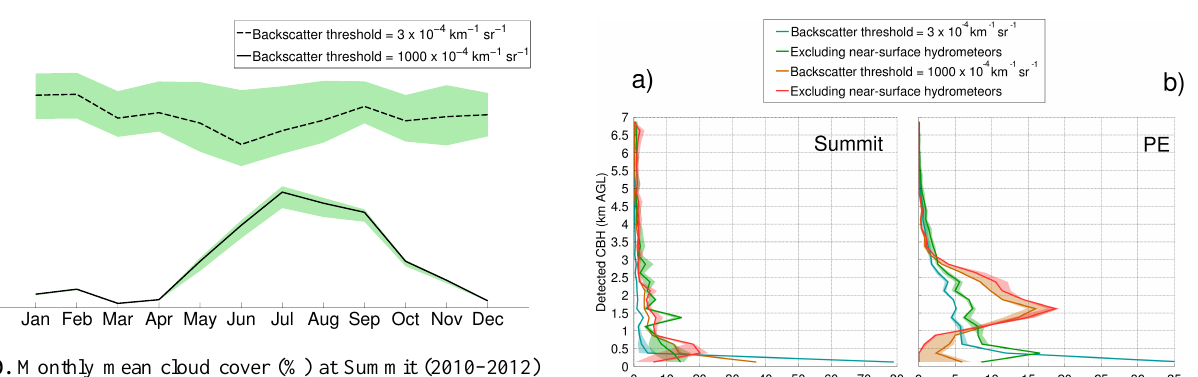
Fig. 10. Monthly mean cloud cover (%) at Summit (2010–2012) derived with sensitive threshold (3 × 10 − 4 km − 1 sr − 1 , dashed line) thereby including optically thin hydrometeor layers and higher threshold (1000 × 10 − 4 km − 1 sr − 1 , solid line) thereby focusing on optically thick hydrometeor layers. The green shaded areas repre- sent uncertainty due to SNR-threshold choice.